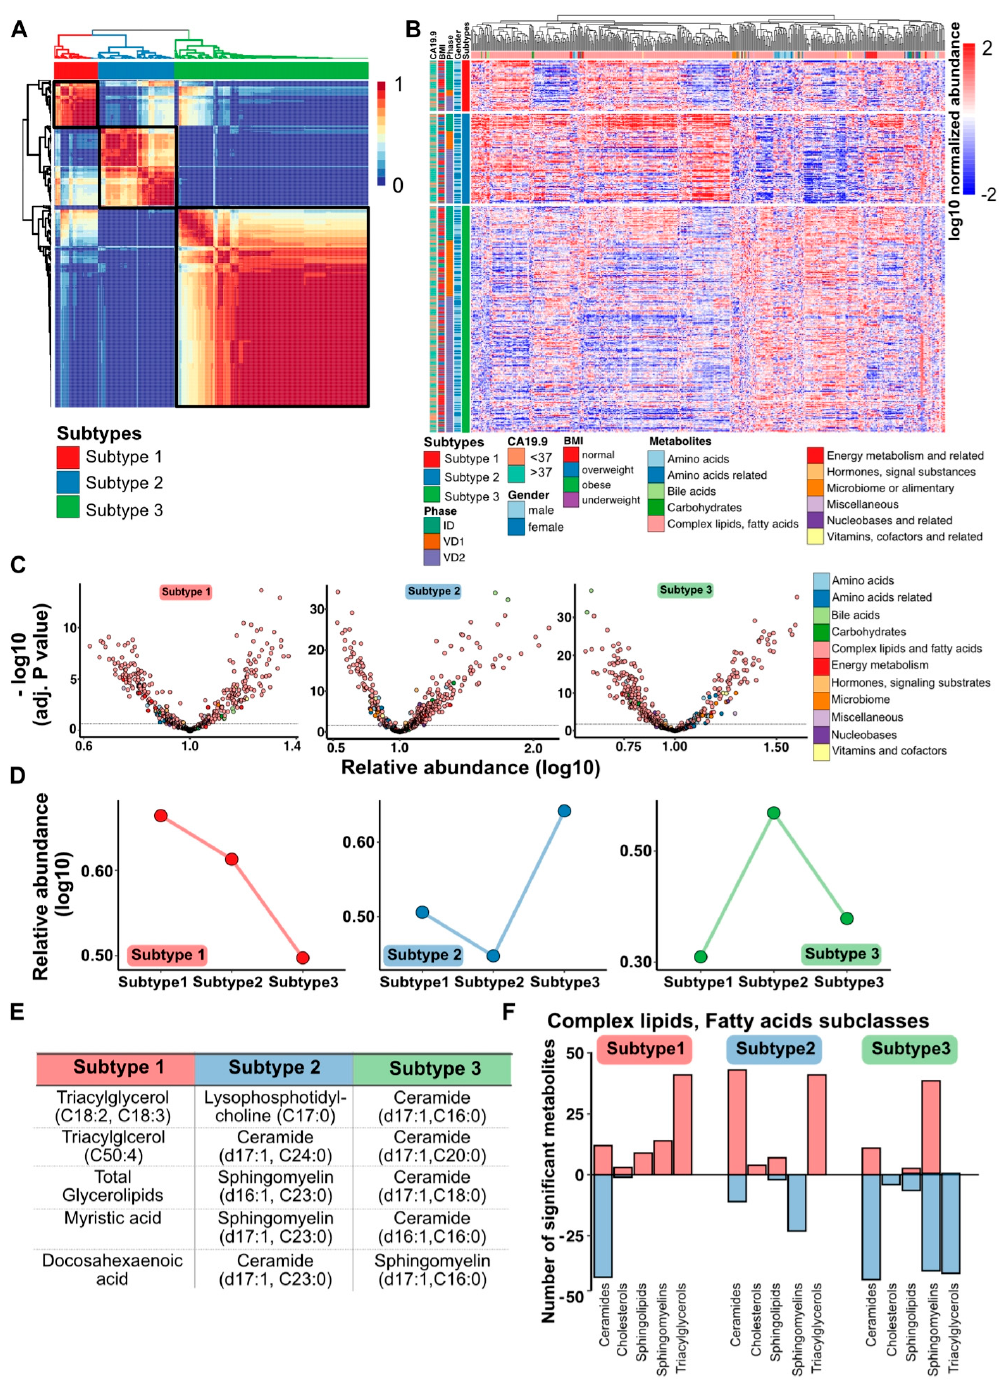
Figure 2. Metabolic classification of the PDAC disease cohort: ( A ) unsupervised consensus classification of PDAC lipidomics data representing 361 patients using non-negative matrix factorization (NMF). ( B ) Heatmap of three consensus clusters based on plasma metabolome profiling. Data are shown as log10 normalized abundance of the metabolites. ( C ) Distribution of detected metabolites according to p -value in each subtype. Relative abundance is normalized by log10. ( D ) Median differential distributions of top 30 identified metabolites from each subtype. ( E ) Table shows a list of top 5 discriminative metabolites from each subtype. ( F ) Bar graph exhibits the 5 prominent subclasses from complex lipid and fatty acid classes, with significant fold changes per subtype compared to the rest. Red bar depicts upregulated metabolites, whereas blue bar denotes downregulated